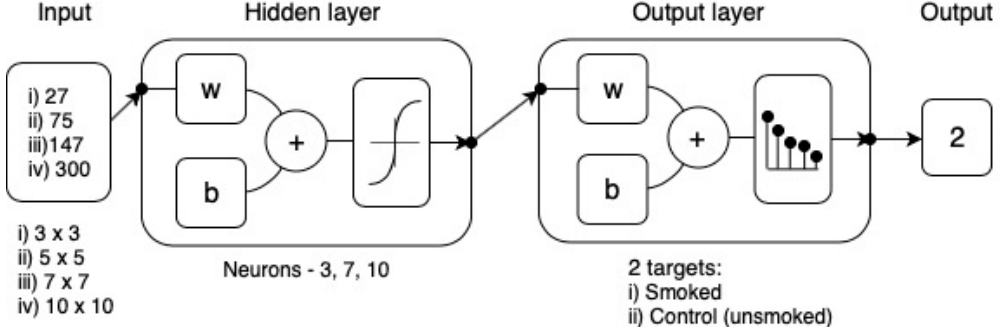
Figure 3. Diagram of the two-layer feedforward network with a tan-sigmoid function in the hidden layer and a Softmax transfer function in the output layer. For hidden and output layers, w = weights and b = biases. Input volume and neuron trimming exercises are included in the diagram.